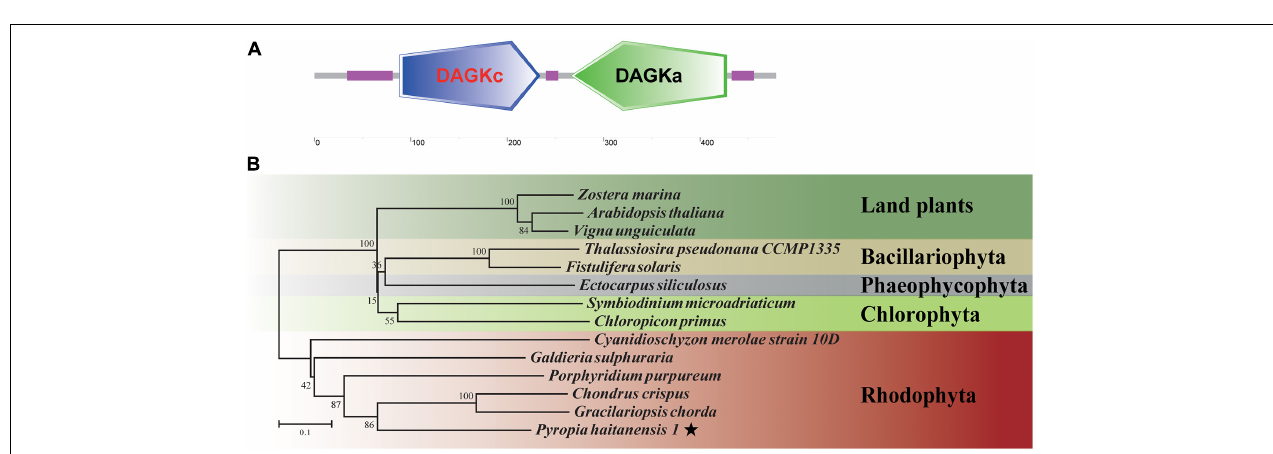
FIGURE 6 | Analysis of conserved domains and phylogenetic relationships of PhDGK1 . (A) Protein-conserved domain prediction of PhDGK1 . Green box indicates diacylglycerol kinase accessory domain (DGKa), blue box indicates diacylglycerol kinase catalytic domain (DGKc), purple boxes indicate regions of low complexity. (B) Phylogenetic relationships of PhDGK1 from P. haitanensis and related proteins from representative Cyanophyta, Chlorophyta, Phaeophyta, and land plant species. Phylogenetic tree was constructed using the maximum-likelihood method. Bootstrap values after maximum-likelihood analysis and posterior probabilities after the Bayesian analysis are indicated at nodes and branches,